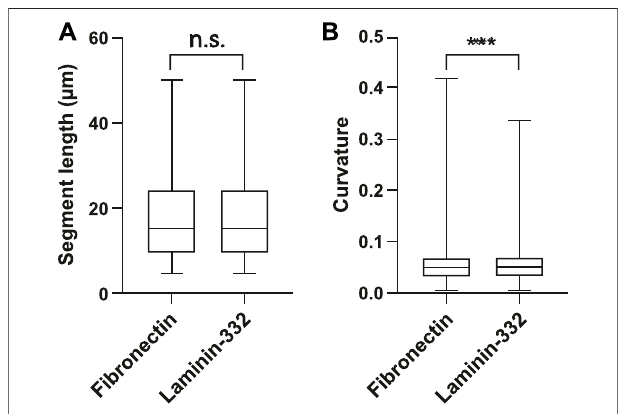
FIGURE 4 | Extracellular matrix composition affects KF segment curvature. The whisker box plots summarize the determination of segment length (A) and curvature of KFs (B) in single HaCaT B10 cells ( n = 12 for each condition) growing either on fi bronectin- or laminin-332-coated micropatterns. Segment lengths are not affected, whereas the segments are signi fi cantly more curved in cells grown on laminin-332 substrate. n = 4830 segments ( fi bronectin) n = 6211 segments (laminin-332). *** p < 0.001; n. s., not signi fi